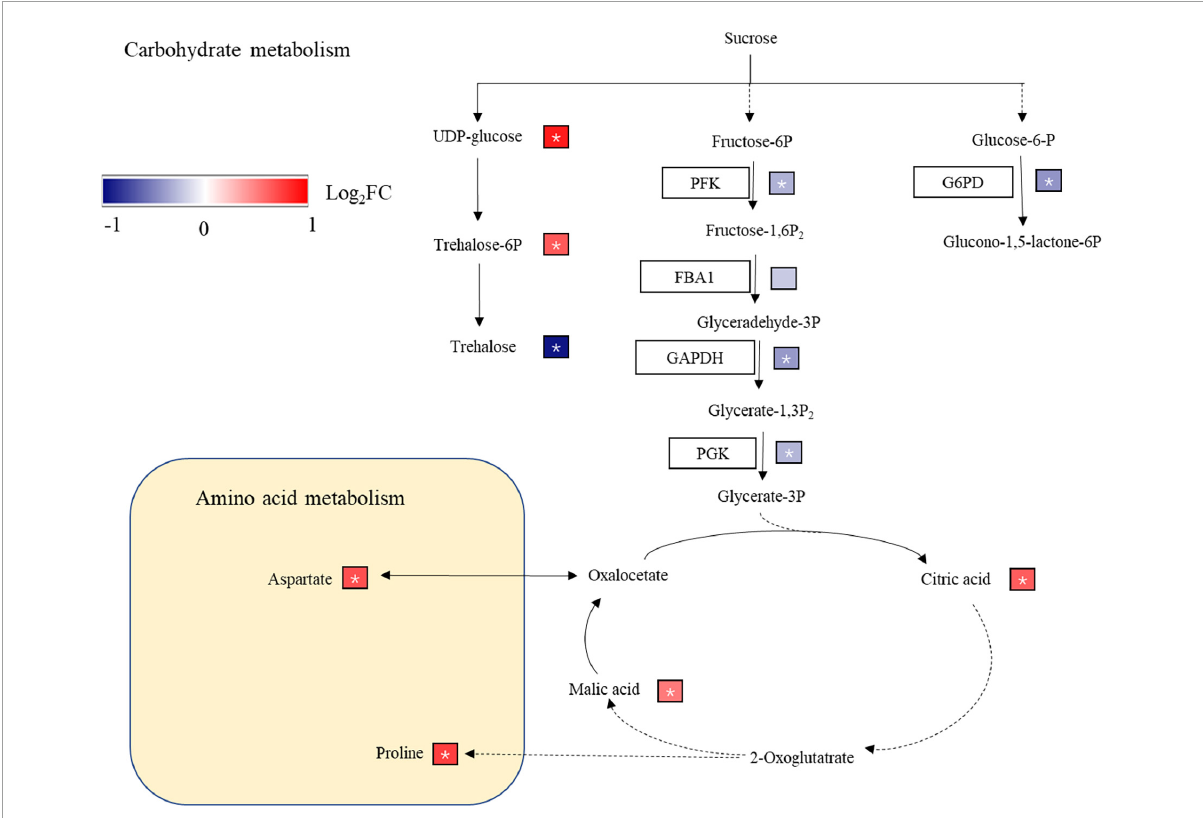
FIGURE7 Carbon metabolism and amino acid biosynthesis pathway. G6PD, glucose-6-phosphate 1-dehydrogenase; PFK, 6-phosphofructokinase; FBA1, fructose-bisphosphate aldolase; GAPDH, glyceraldehyde-3-phosphate dehydrogenase; PGK, phosphoglycerate kinase; GOT1, aspartate aminotransferase; mdh, malate dehydrogenase. The different protein expression levels changes were represented by log 2 (FC) in expression. Red and blue indicate upregulated and downregulated proteins, respectively,* indicates a significant